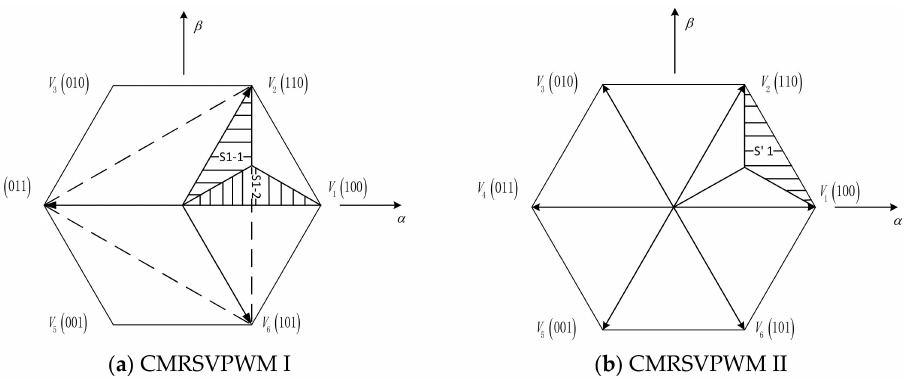
Figure 4. Sectors of